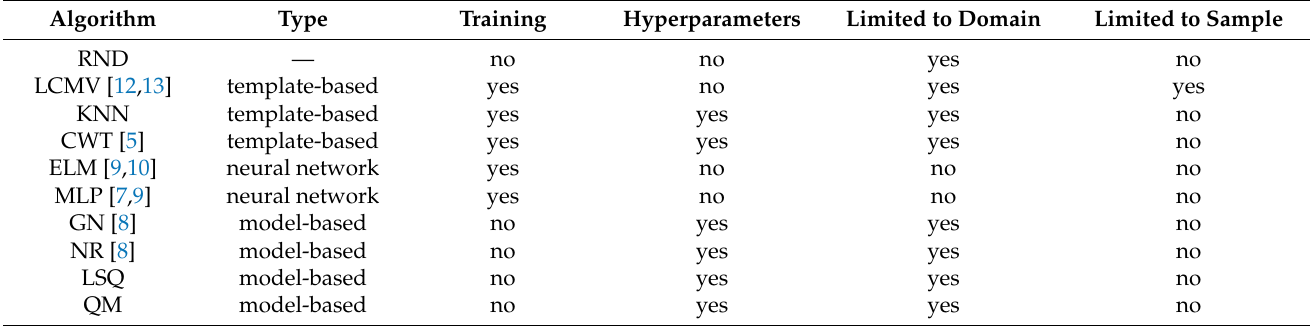
Table 2. Properties of the dipole localisation algorithms. The ‘Limited to domain’ column indicates whether the algorithm can produce predictions outside the simulated domain (see Figure 2). The ‘Limited to sample’ column indicates whether the algorithm is able to produce a prediction that is not present in the training